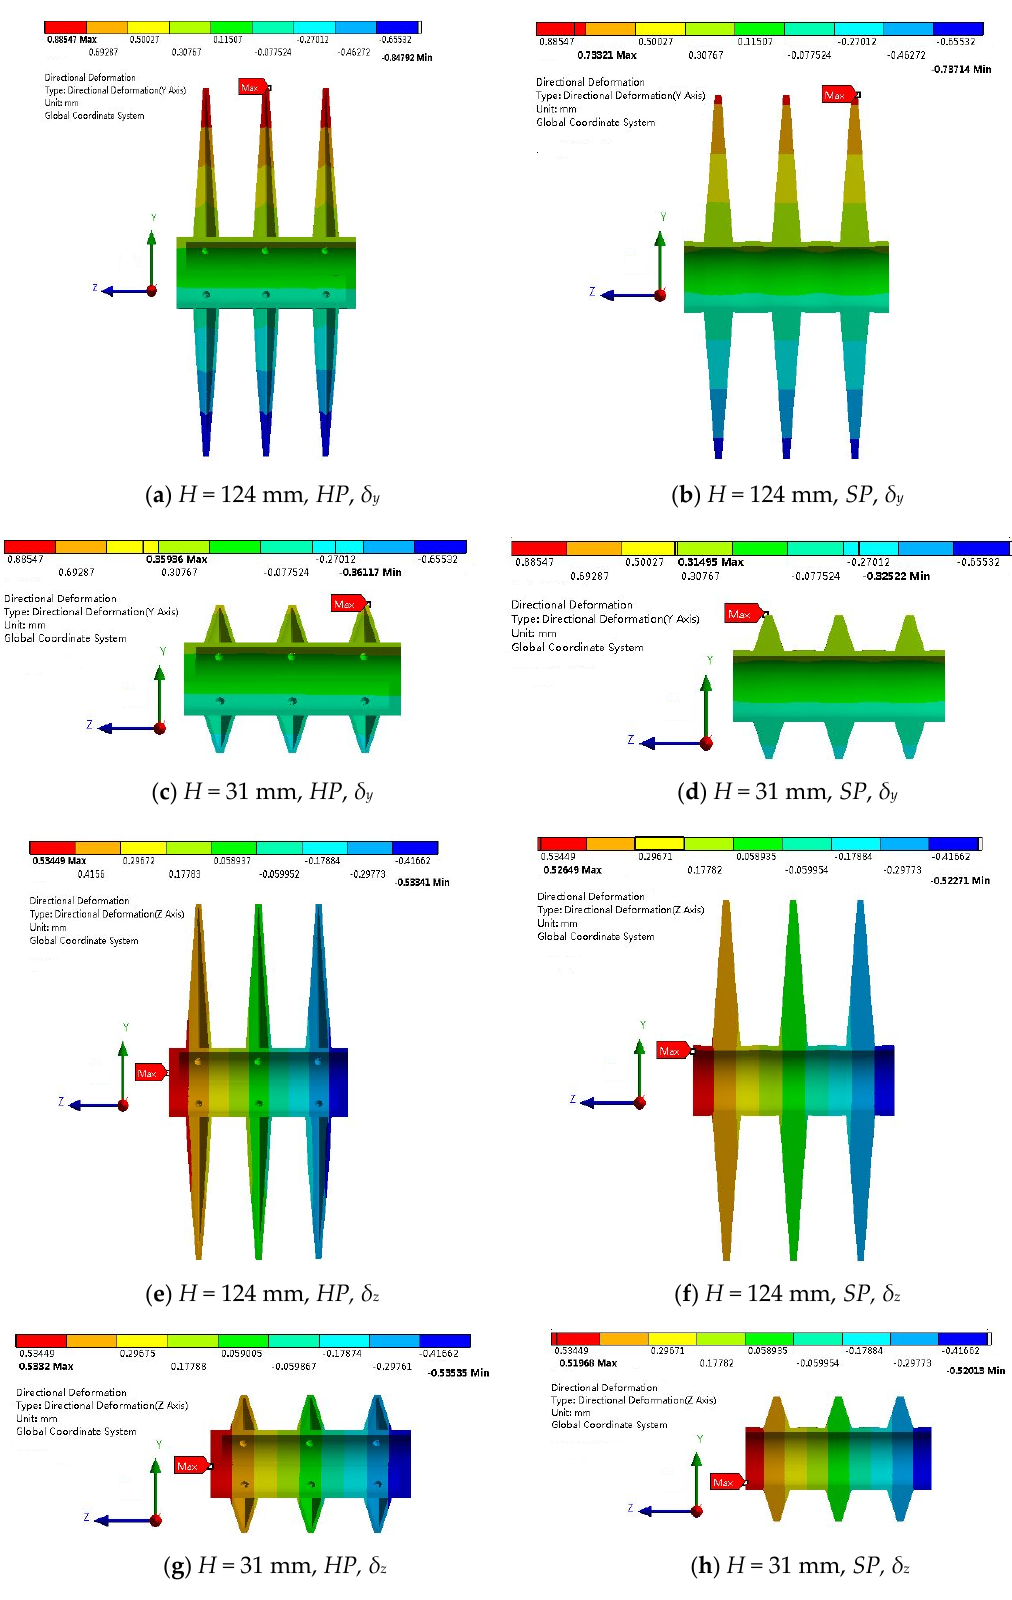
. m = 1 kg / s, ∆ T = 100 ◦ C,